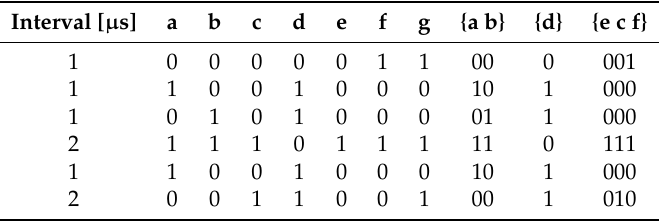
Figure 3. Input patterns extraction. Example circuit and its respective operational scenario used to explain the process to extract the input patterns distribution. Table 1. Intermediate table of the input patterns extraction process. Tabular representation of the operational scenario illustrated in Figure